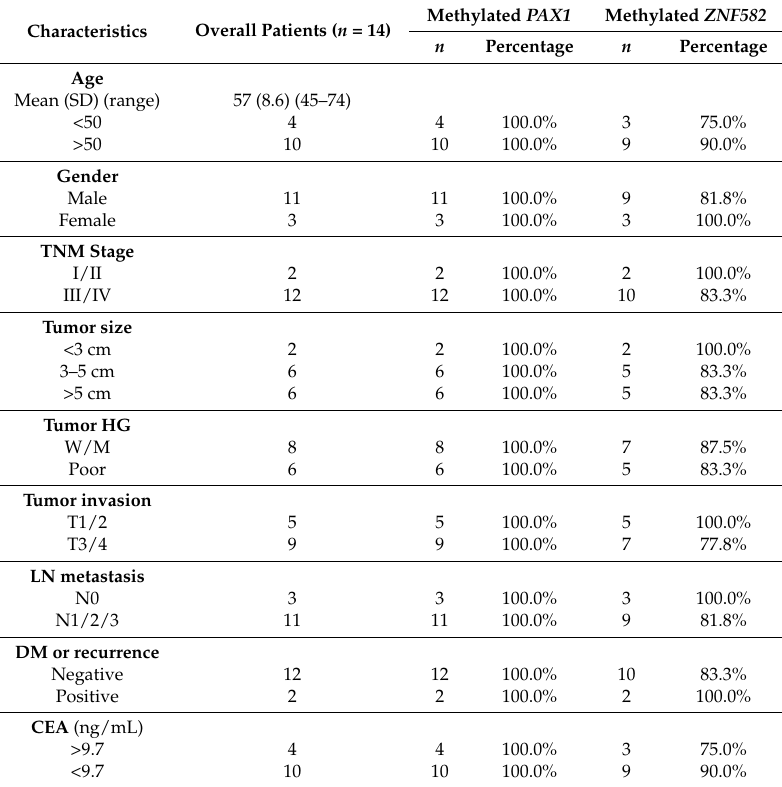
Figure 2. Receiver operating characteristic (ROC) curve analysis of PAX1 ( A ) and ZNF582 ( B ). The area under the ROC curve (AUC) of each gene was calculated for the diagnosis of ESCC tumors. The arrow indicates the best sensitivity and specificity.